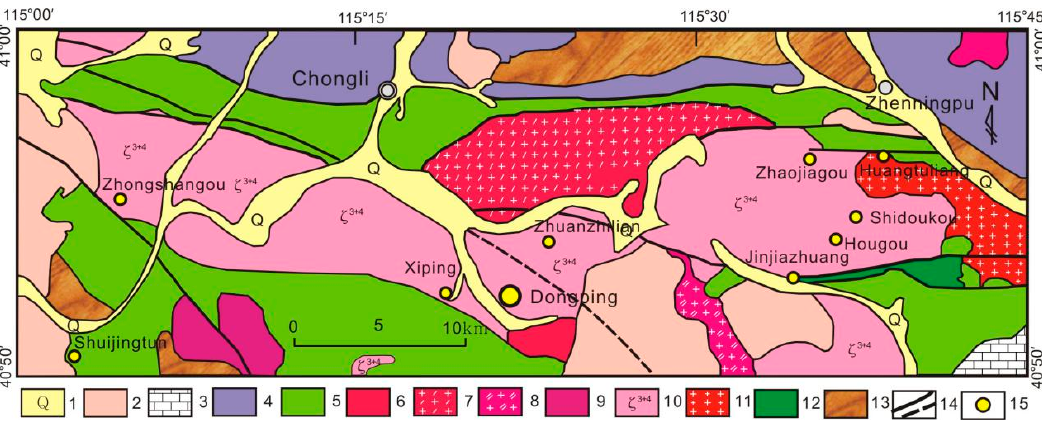
Figure 1. Simplified geological map of Shuiquangou alkaline complex in Zhangjiakou area, Hebei Province China (modified after Li et al. [5]; Song et al. [7]). (1) Quaternary; (2) Yanshanian intermediate ‐ acidic volcaniclastic rocks; (3) Neoproterozoic and Mesoproterozoic cover rocks; (4) Paleo Proterozoic Hongqiyingzi Group; (5) Archean Chongli Group; (6) Shuiquan potassium granite; (7) Honghualiang biotite granite; (8) adamellite; (9) porphyritic granite; (10) Shuiquangou alkaline complex; (11) Hot spring giant porphyritic granite; (12) Ultramafic rocks; (13) Achaean granite gneiss; (14) faults; (15) gold deposits.